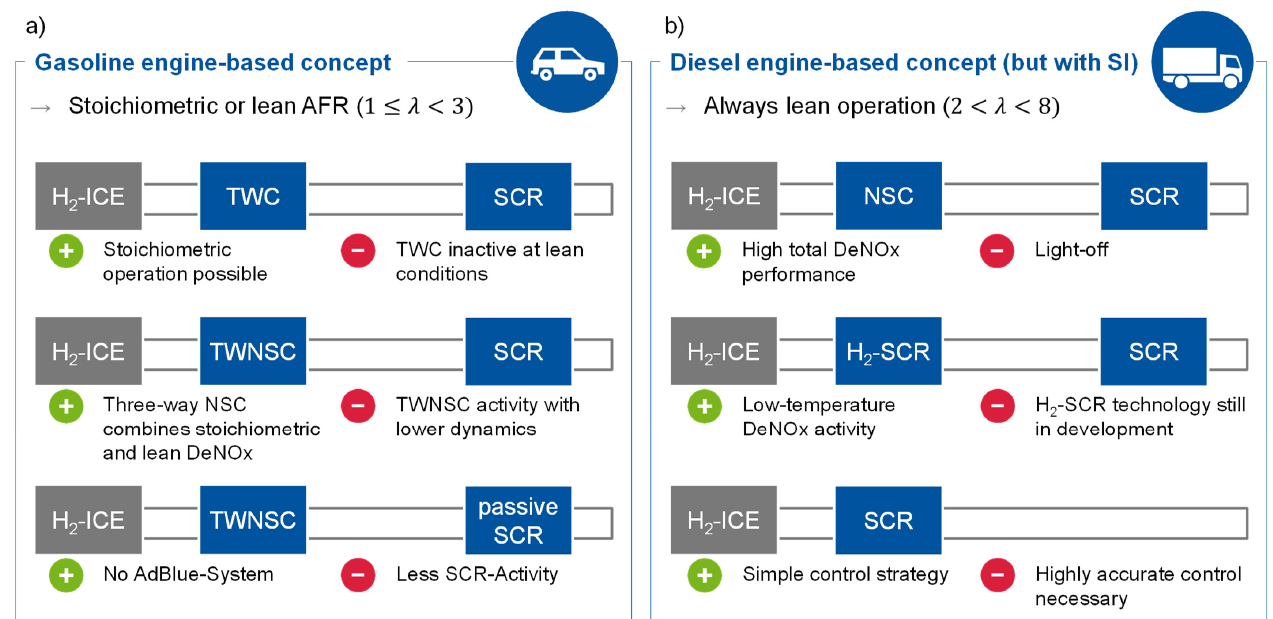
Figure 6. Aftertreatment system layout for ( a ) the gasoline engine-based concept including stoichiometric operation and ( b ) the HD diesel engine-based concept at always lean conditions.